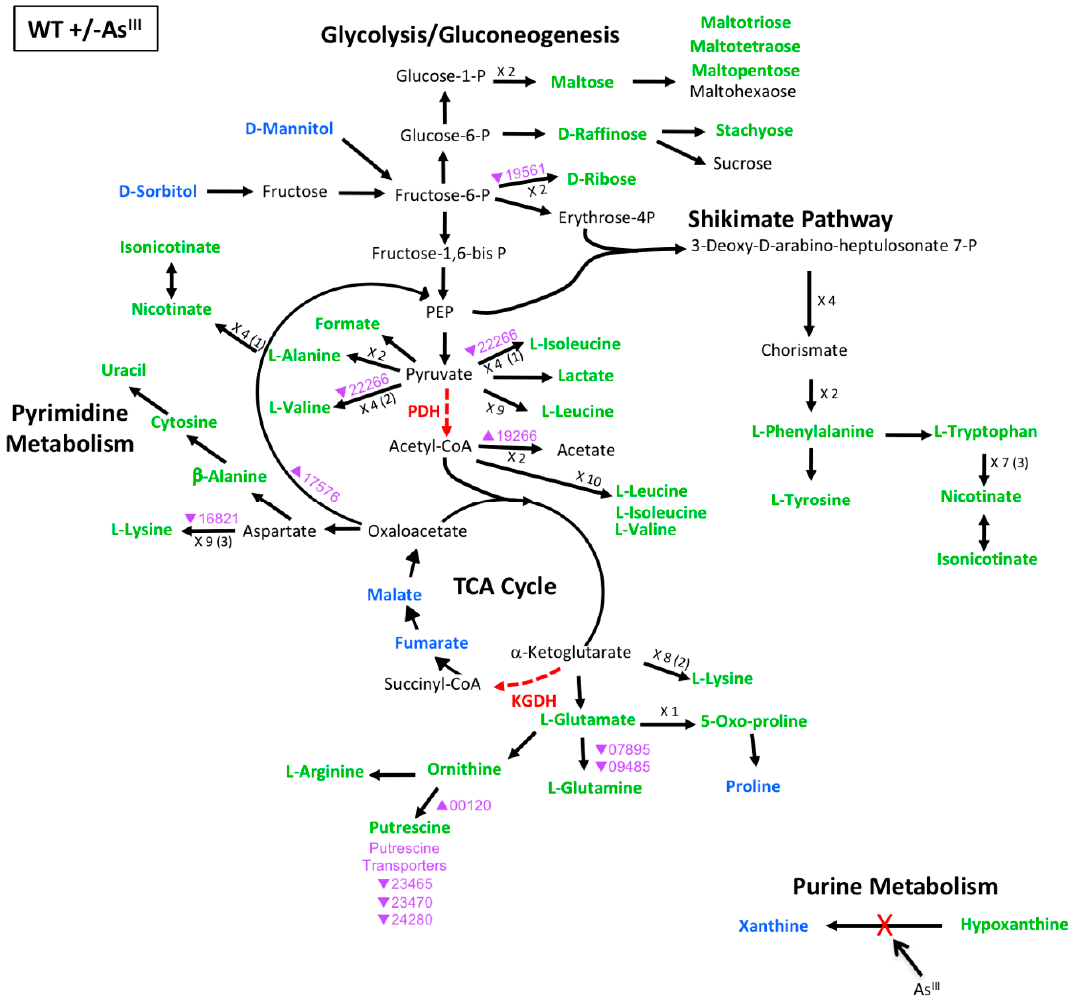
Figure 3. Model of carbon metabolism in the WT during As III exposure, with mannitol being the initial substrate. Reaction steps were derived from KEGG pathway maps using the most parsimonious routes of metabolite formation, noting that not all enzyme reaction steps are depicted in the model. When multiple intermediates are involved between illustrated metabolites, the number of reactions is shown; i.e., × 3, with the number of intermediates identified shown in parentheses. Green text denotes metabolites increased in abundance; blue text denotes metabolites decreased in abundance. Red dashed vector arrows indicate reactions suggested to be inhibited by As III ; (PDH = pyruvate dehydrogenase; KDGH = alpha-ketoglutarate dehydrogenase). Transcripts are denoted by AT5A identification number (purple text), with a triangle indication increased expression ( ← ) or decreased expression ( ↔ ) upon As III exposure.